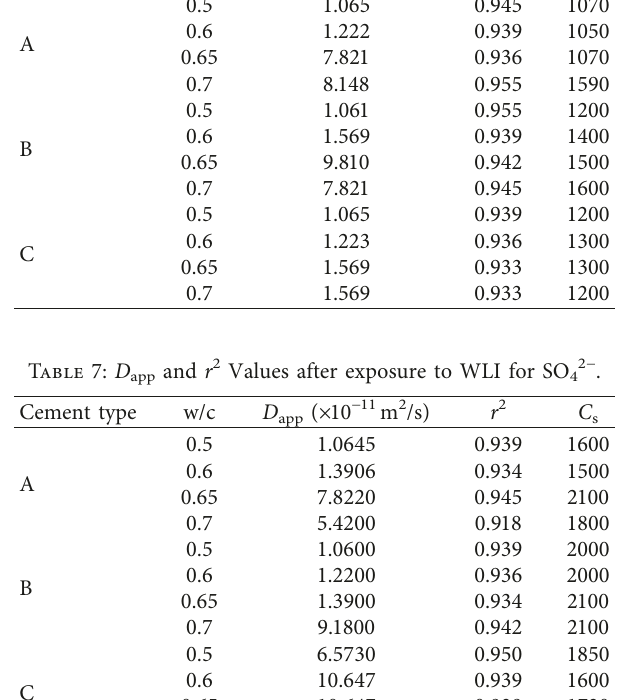
Table 6: D 2 values after exposure to SW for SO 42 − . app and r Cement type